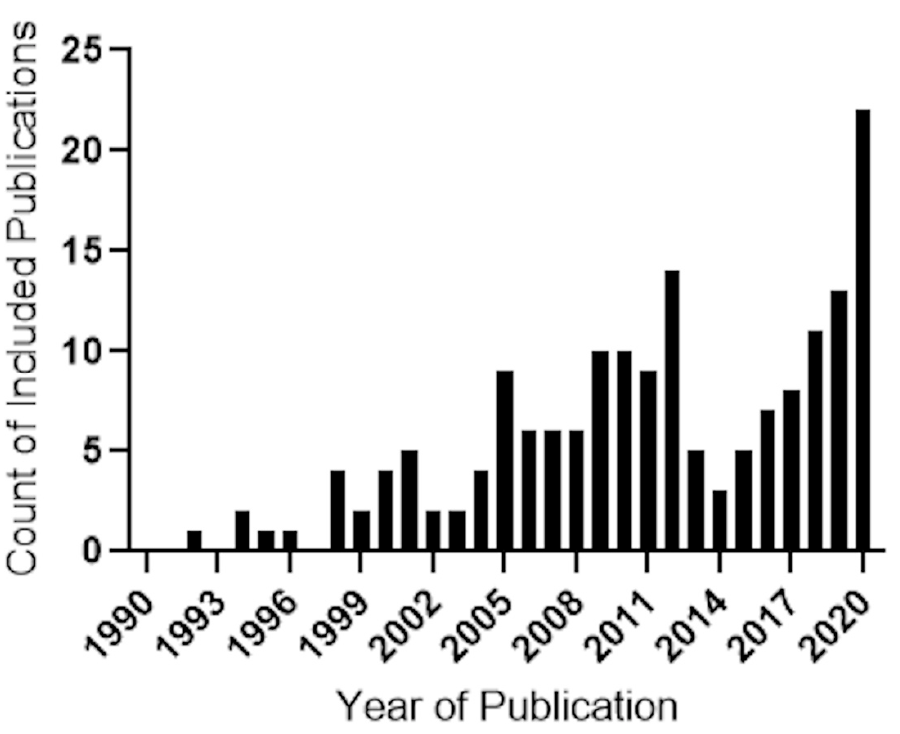
Figure 4. Frequency histogram of 172 publications, derived from a systematic search of cerium oxide literature, conducted in the Scopus database for search terms: “cerium oxide OR ceria OR nanoceria OR nano ceria” AND doping-additives/catalysts/reactive oxygen species/pathology, showing the surge of publication activity across all four themes between 2019–2020. The year of 2020 demonstrating the highest number of publications. Accessed on 17 September 2020.